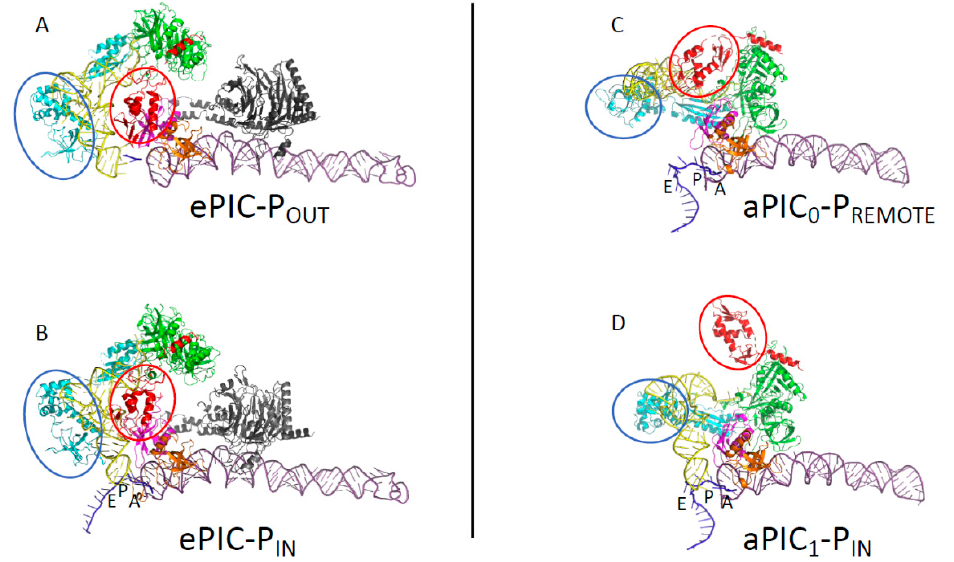
Figure 4. A c omparison of archaeal and eukaryotic initiation complexes. The figure shows partial views (P site region) of eukaryotic and archaeal initiation complexes. ( A ) The eukaryotic 48S ‐ open P OUT complex. ( B ) The eukaryotic 48S ‐ closed P IN complex. ( A ) and ( B ) are from [134] (PDB ID 3JAQ, 3JAP). ( C ) The archaeal PIC0 ‐ P REMOTE conformation. ( D ) The archaeal PIC1 ‐ P IN conformation.